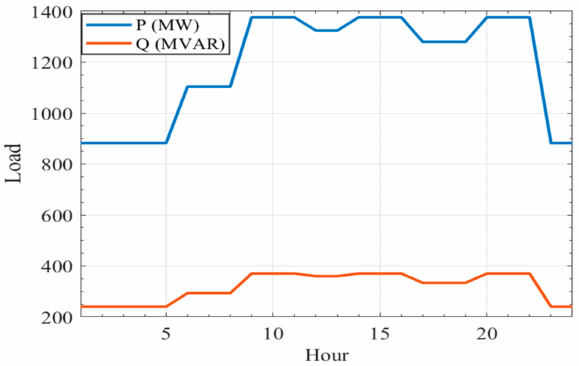
Figure 5. Hourly load values of the 57-bus system.